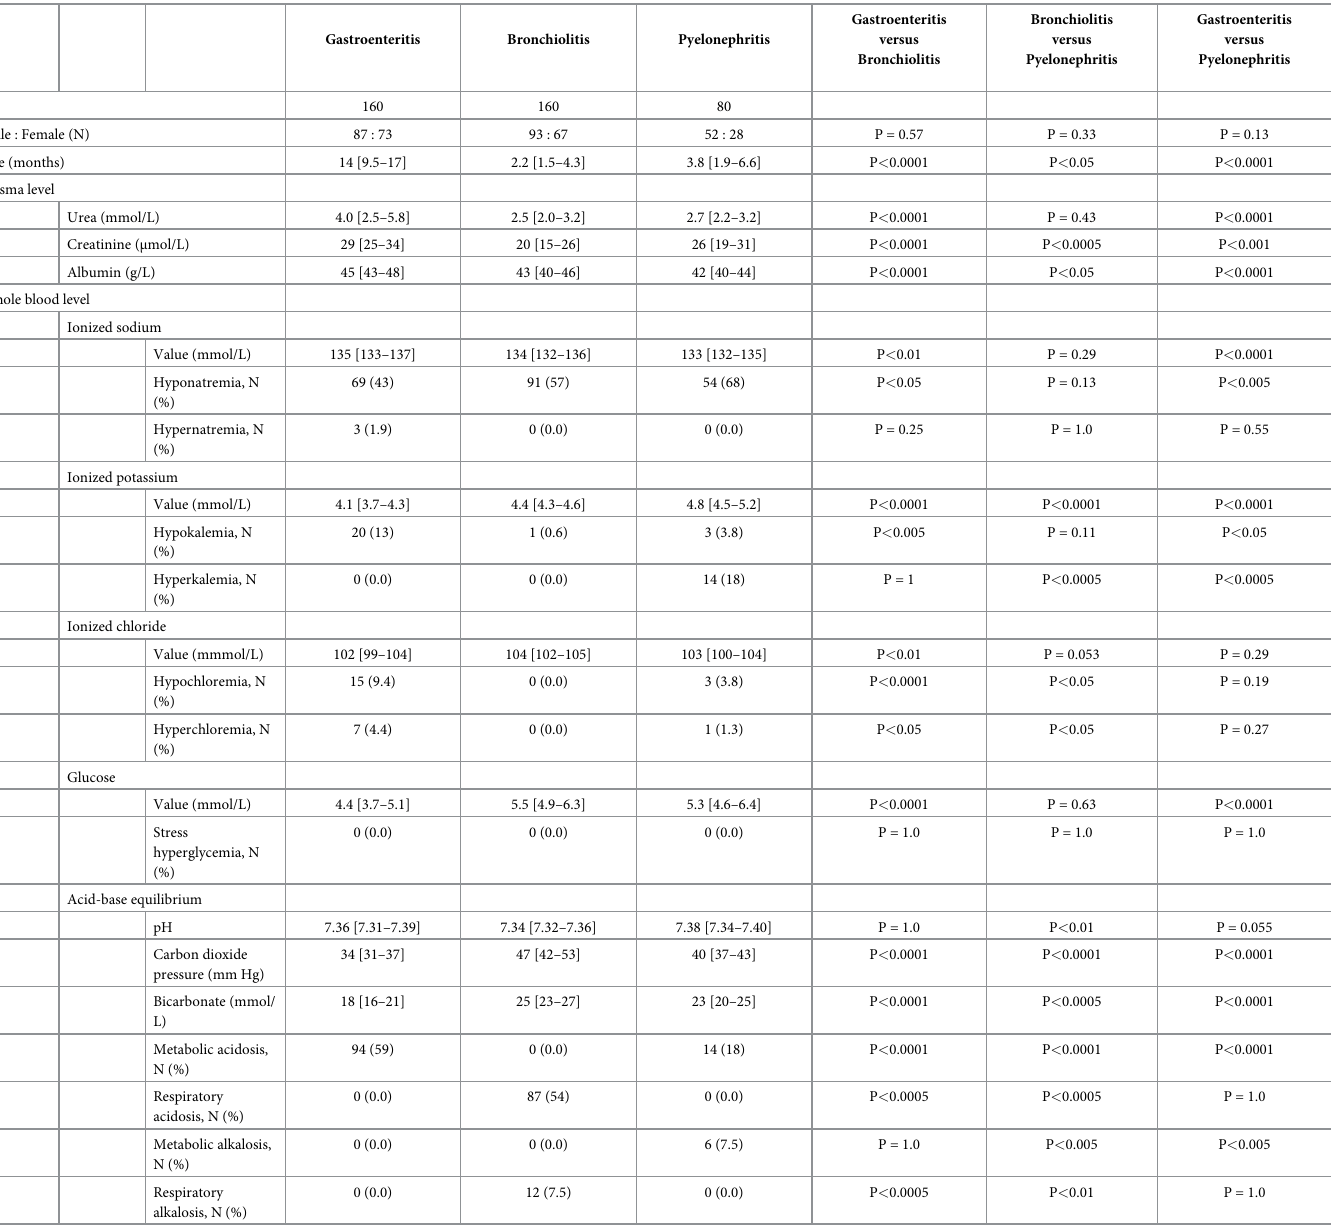
Table 1. Clinical and laboratory data on hospital